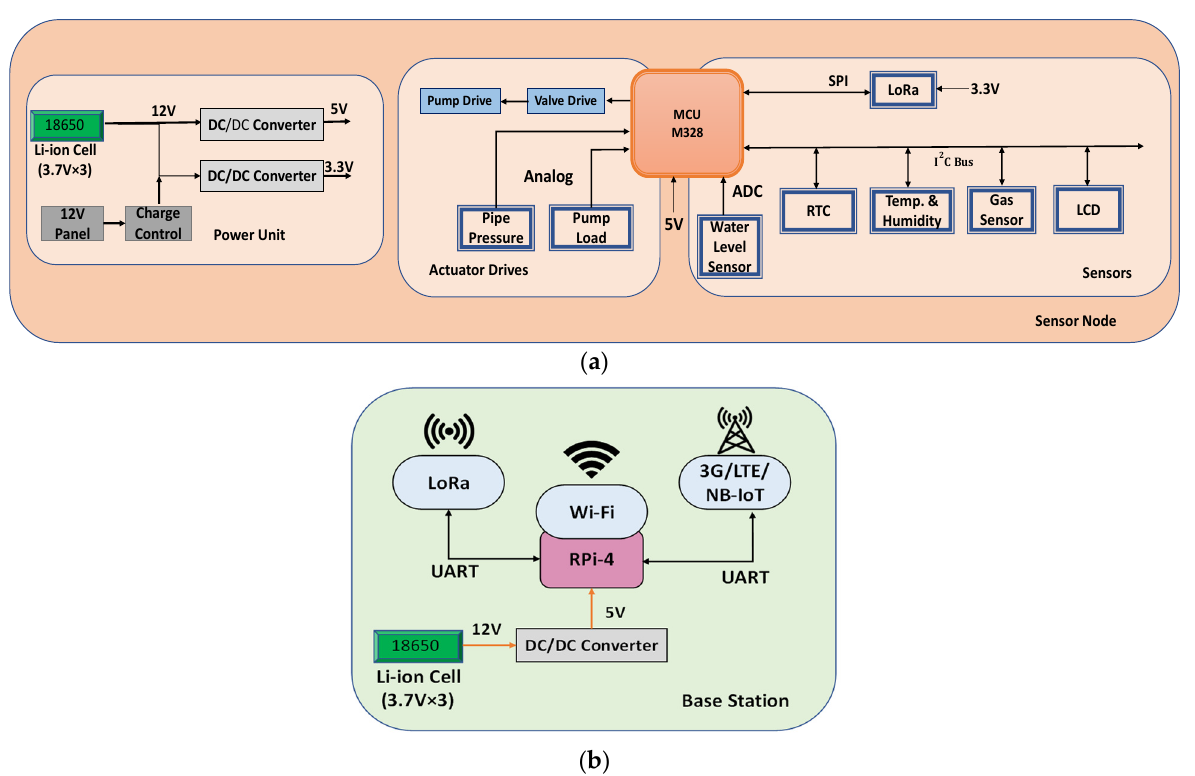
Figure 7. Hardware block diagram showing ( a ) Sensor node consisting of sensors, actuator drivers, and power unit; ( b ) base station (BS) with LoRa and cellular data